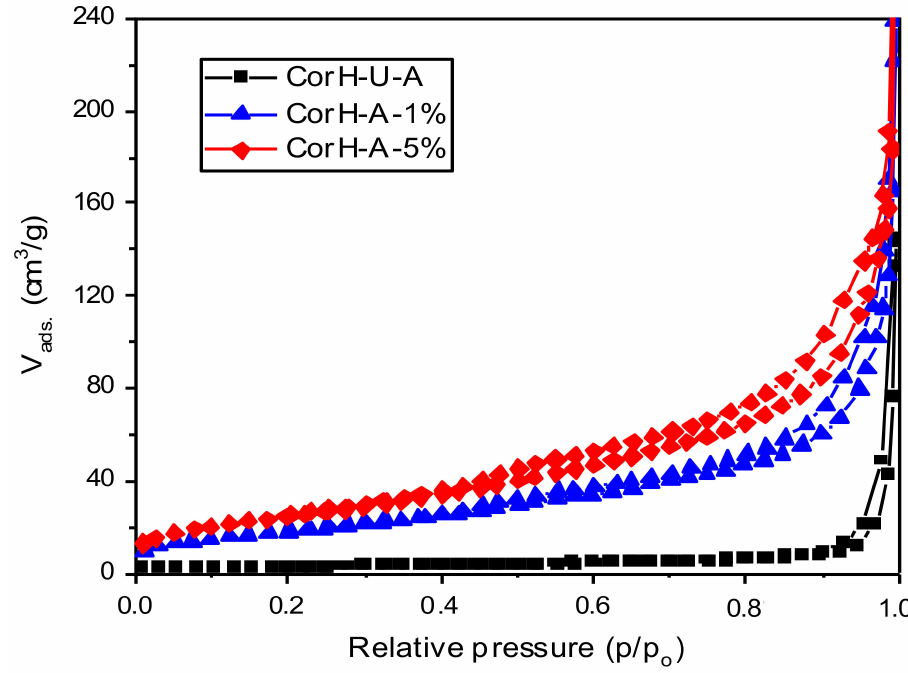
Figure 6. Adsorption–desorption isotherms of ashes from untreated and treated cornhusk. Table 4. Comparison of the structural characteristics (S BET and pore volume V P ) of ashes derived from biomass fuels leached in 1 w / v % CA and 5 w / v % CA at a combustion temperature of 600 ◦ C and residence time of 2